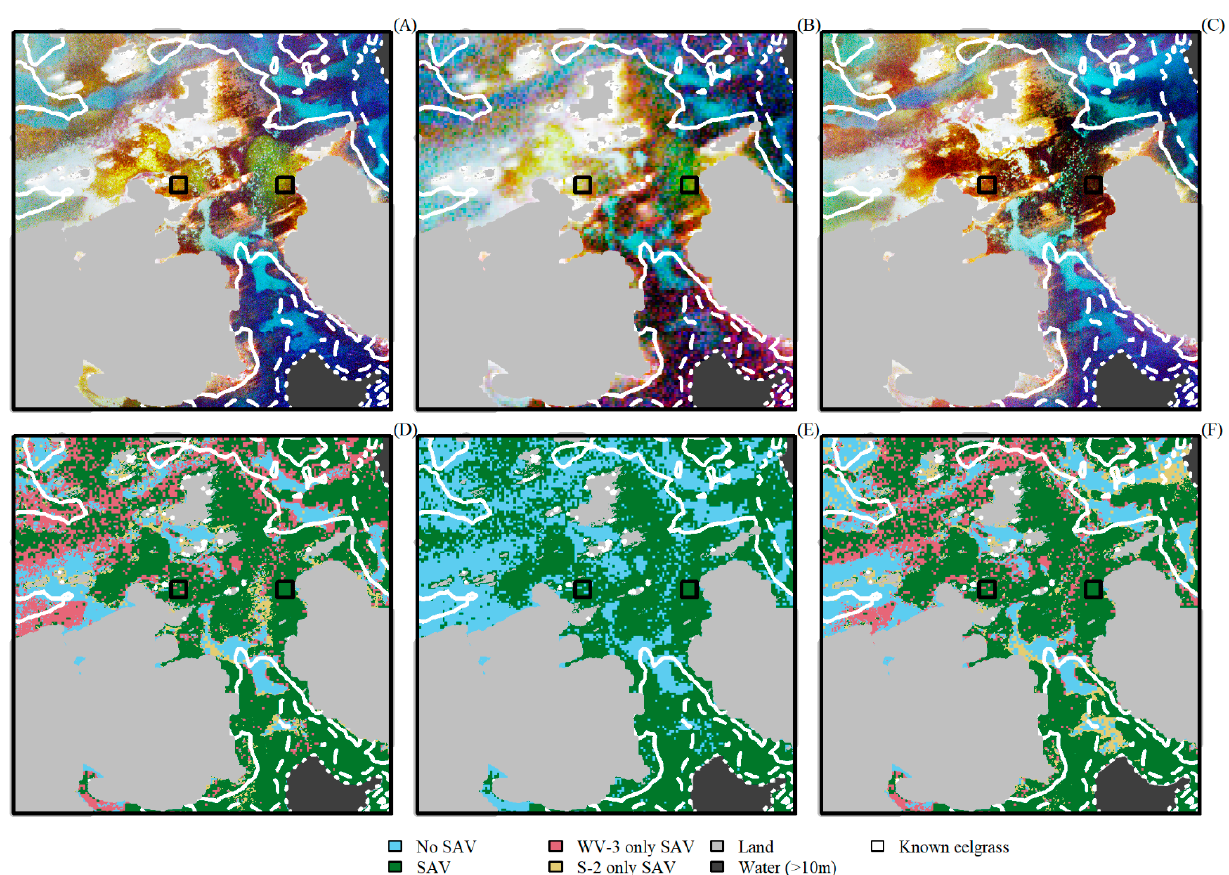
Figure 11. Comparing the impact of tidal height across the top performing WorldView-3 classifications relative to the full tile Sentinel-2 classification. Top row true colour composites, bottom row bottom habitat maps for the low tide 11 August WorldView-3 image ( A , D ), low tide Sentinel-2 image ( B , E ), and high tide 17 August WorldView-3 image ( C , F ). Known locations of vegetated habitat (specifically eelgrass) are indicated by the black boxes. Light grey corresponds to an image-based land mask. Solid white line corresponds to the 3 m depth contour, long dashed white line corresponds to the 7 m depth contour, short dashed line corresponds to the 10 m depth contour. Light grey corresponds to an image-based land mask.